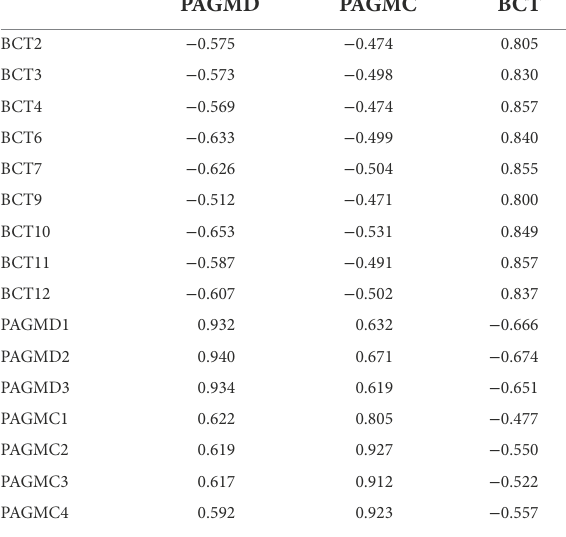
TABLE 5 Assessment of formative